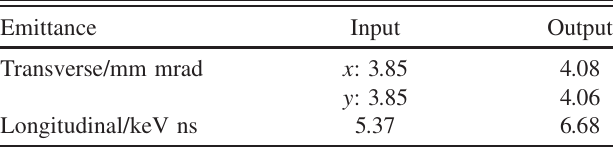
TABLE I. Normalized rms-emittance values for the input and output distribution with 500 mA beam